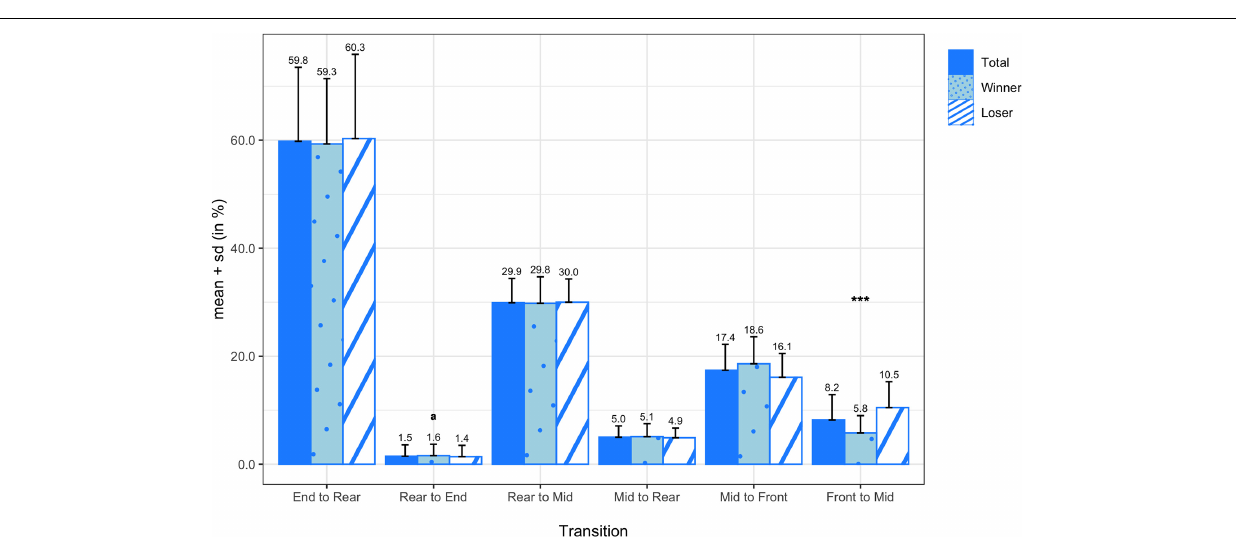
FIGURE 10 | Transition probabilities of passing between adjacent zones for all teams, winning teams, and losing teams. *** denotes a significant difference between winning and losing teams at a significance level of 0.001. Variables compared using a non-parametric test are marked with an a